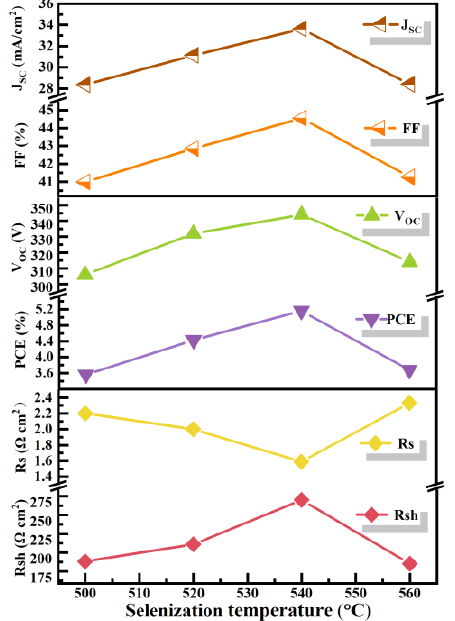
Figure 10. Curves of Jsc, FF, Voc, PCE, Rs, and Rsh as selenization temperature increases.